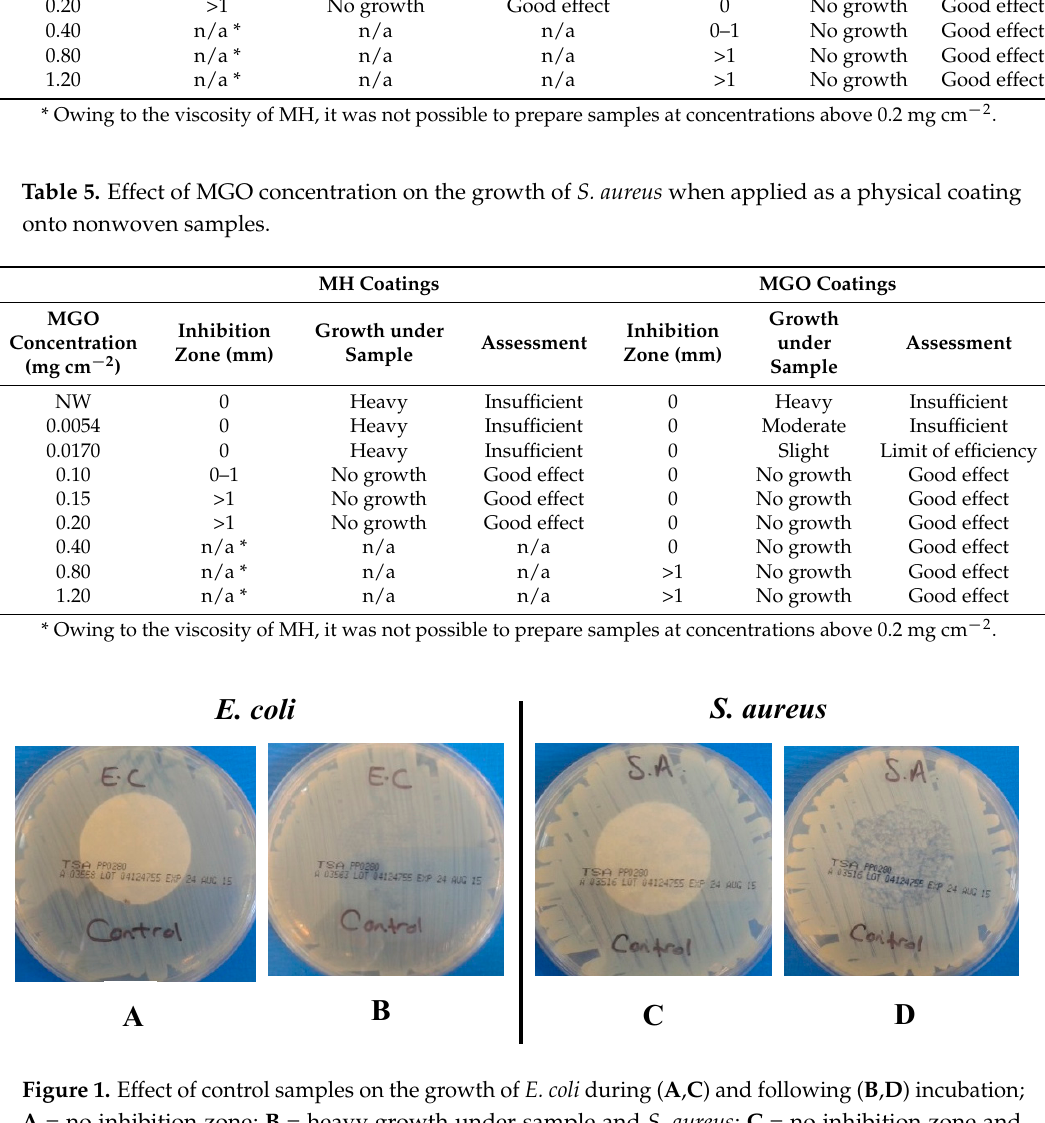
Table 4. Effect of MGO concentration on the growth of E. coli when applied as a physical coating onto nonwoven samples.